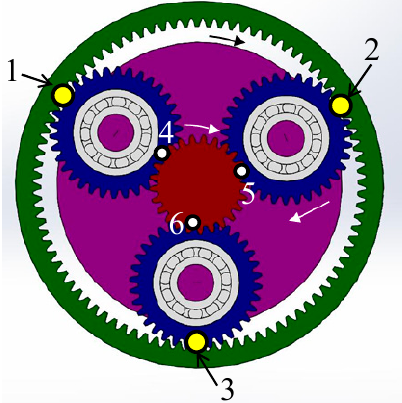
Figure 1. Planetary gearbox model diagram.